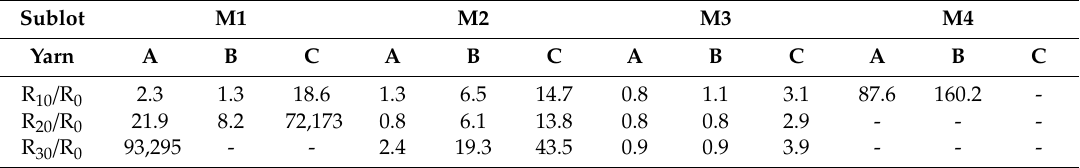
Table 2. Evolution of the sheet resistance of the washed electrodes from different sublots (M1, M2, M3, M4). Sublot M1 M2